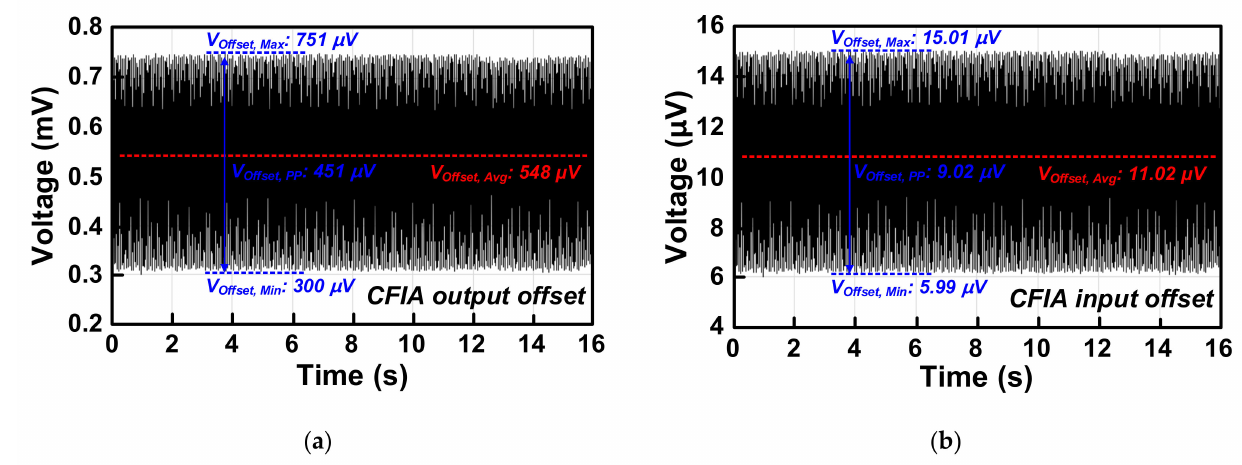
Figure 18. Measured ( a ) output offset and ( b ) input-referred offset.